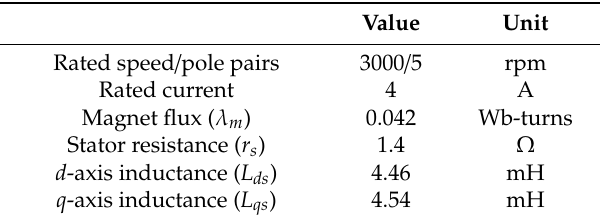
Table A2. Main motor